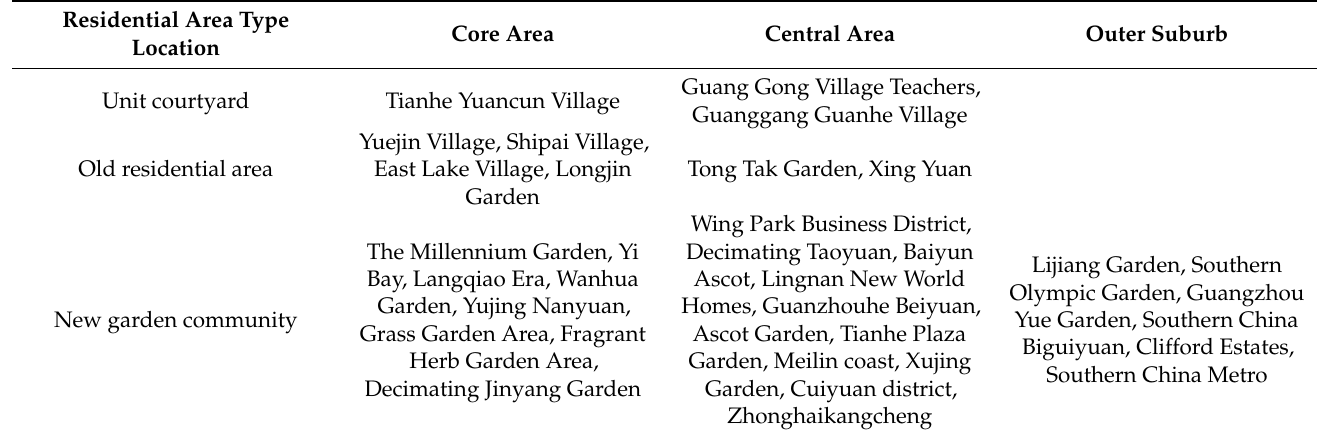
Table 2. Basic information of the